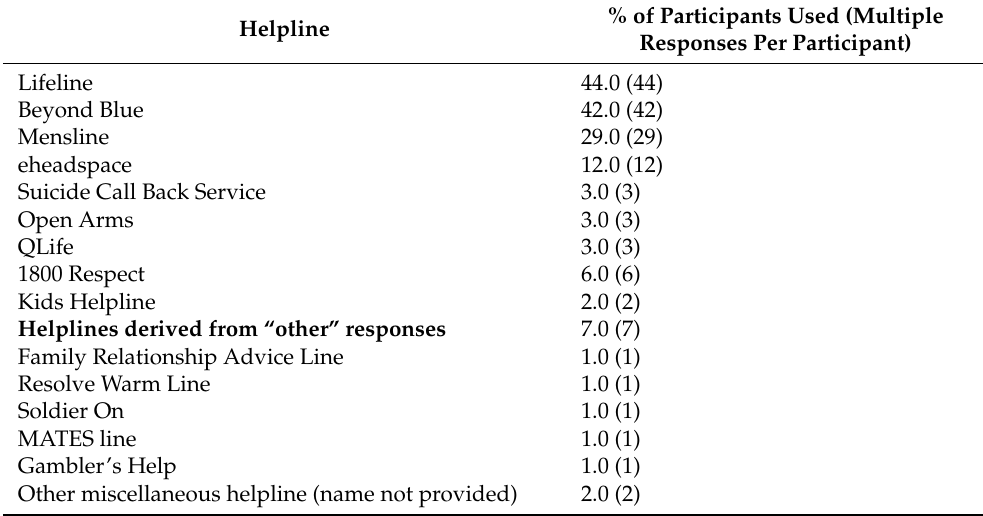
Table 2. Helpline service